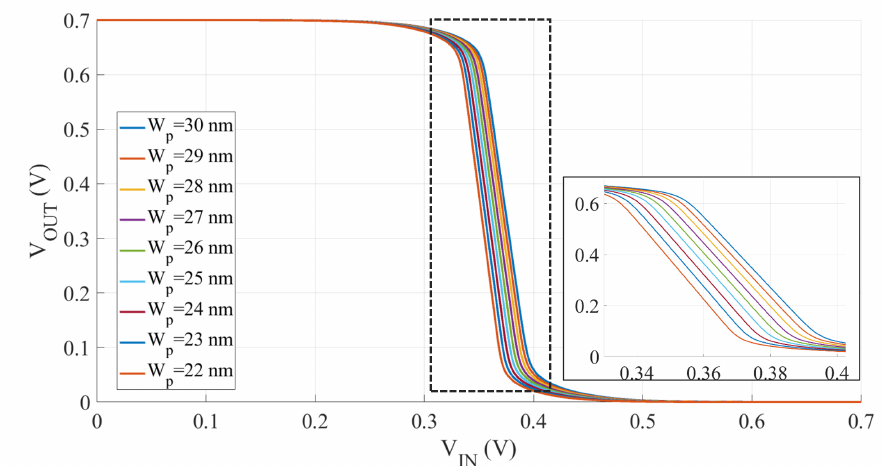
Figure 3. Parametric inverter transcharacteristics V OUT /V IN with different p-type nanosheet width W p and with W n = 30 nm; the inset shows an enlargement of the dashed box portion.